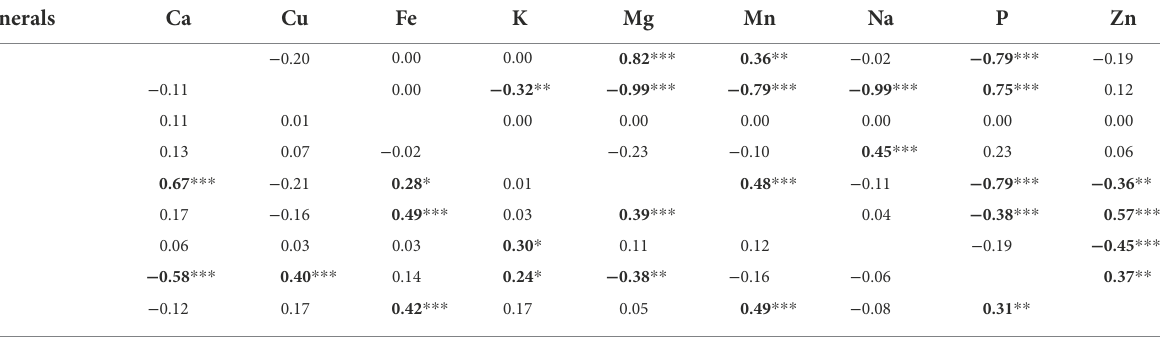
TABLE 4 Phenotypic correlation coefficients (below diagonal) and genotypic correlation coefficients (above diagonal) among nine leaf mineral concentrations in a population of 70 advanced lines of G. gynandra . Minerals Ca